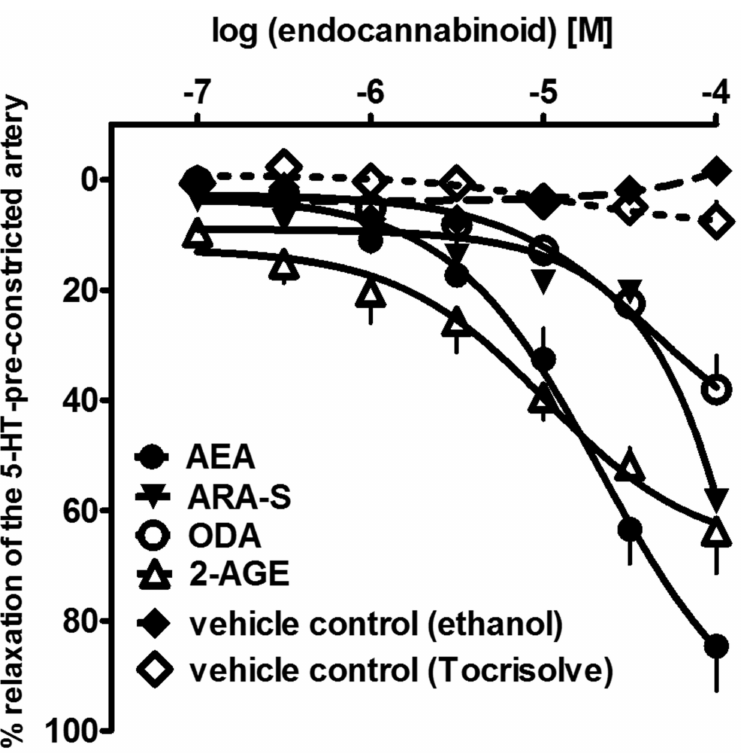
Figure 1. Concentration–response curves of endocannabinoid anandamide (AEA) and endocannabinoid-like molecules: N-arachidonoyl-L-serine (ARA-S), oleamide; cis-9-octadecenoamide (ODA), noladin ether; 2-arachidonyl-glycerol ether (2-AGE) or vehicles for their vasorelaxant effects on endothelium-intact rings of isolated human pulmonary artery. Results are expressed as percentage relaxation of the isometric contraction induced by serotonin (5-HT, 1 µ M). Mean ± SEM of 5 tissues is shown for each curve. In few cases, SEM is smaller than or equal to the size of